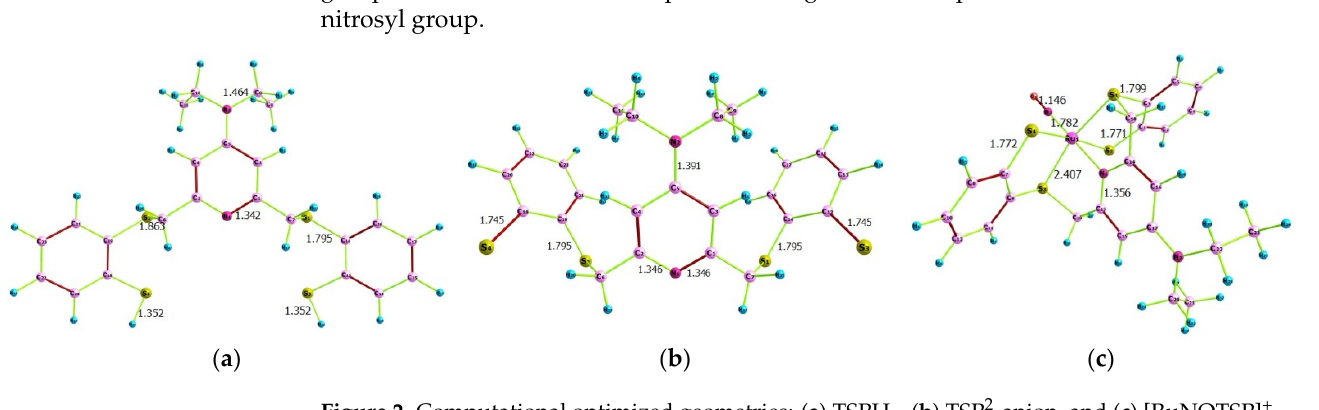
Table 1. NBA charges of selected atoms of TSPH 2 , TSP 2 − anion, and [RuNOTSP] + at B3LYP/3-21G(d).